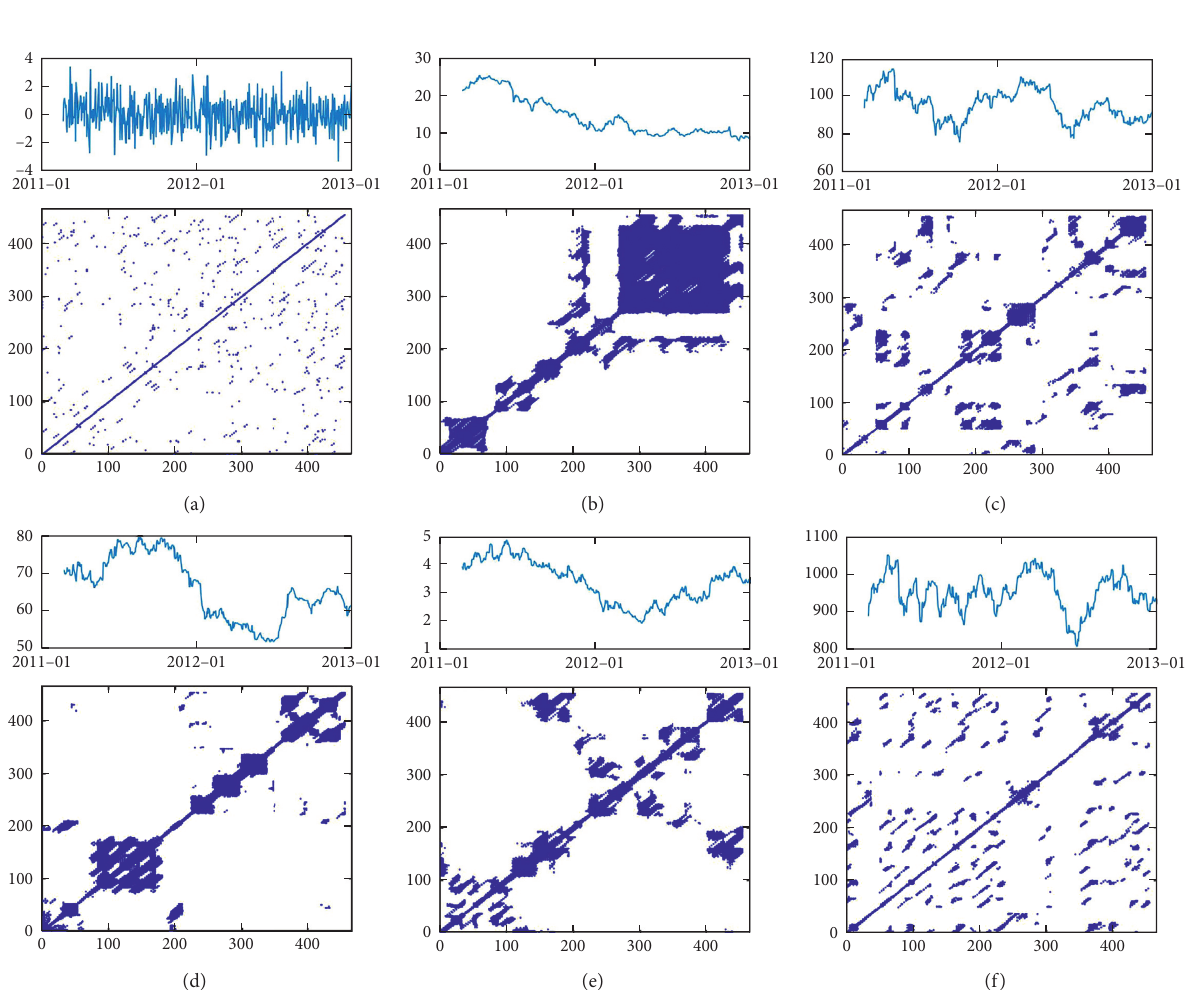
Figure 4: Recurrence plot of carbon and energy prices from 22 February 2011 to 31 December 2012. (a) Gaussian noise, (b) Carbon price, (c) WTI Crude oil price, (d) Coal price, (e) Natural gas price, (f) Gasoline price.